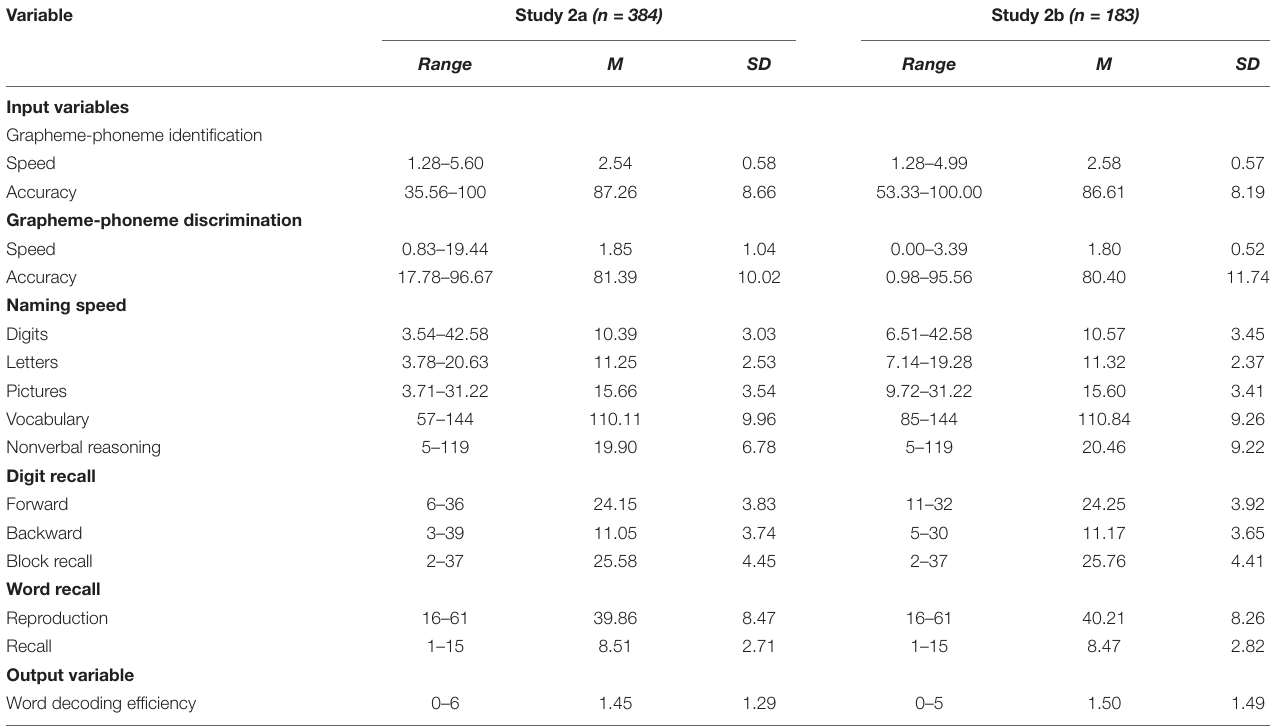
TABLE 5 | Descriptive statistics for input variables and output variable of the models.